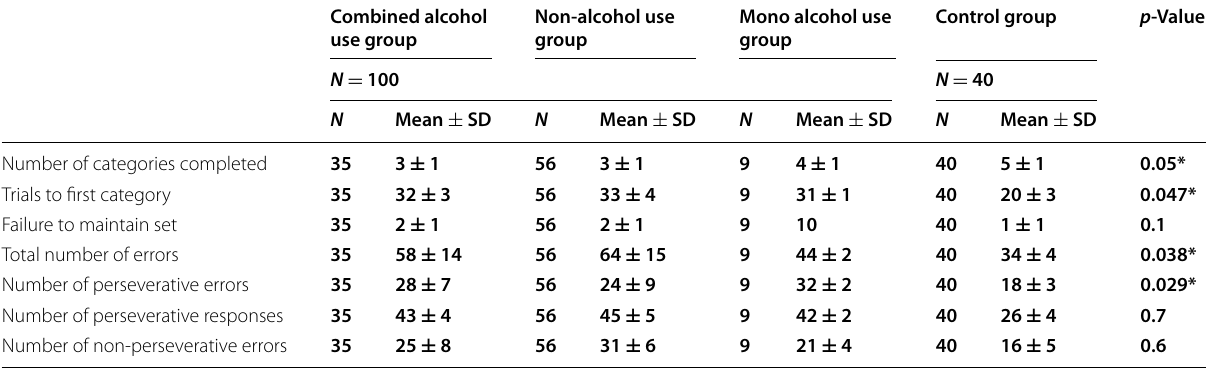
* p -value < 0.05 significance. Shows that mono alcohol use group showed a higher mean than control, non-alcohol use group as regard number of perseverative errors, and the difference had statistically critical ( p 0.029) which means that alcohol use might affect flexibility domain critical. Mono alcohol use and control = groups showed a lower mean than combined alcohol use group and non-alcohol user group as regard total number of errors, and the difference had statistically critical p 0. 038. Mono, combined, and non-alcohol use groups show lower mean than control groups as regard number of category completed and higher mean = than control as regard numbers of trial to first category, and the difference had statistically critical p =